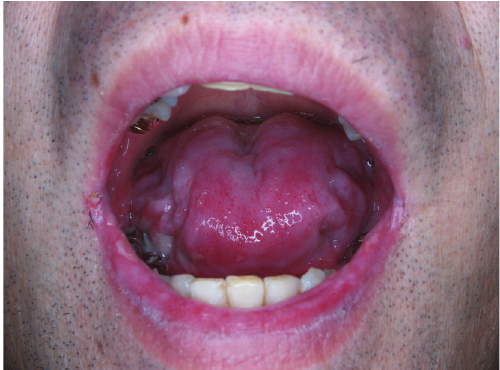
Figure 3: Histological findings of the skin lesion. Subcorneal bulla with mild acantholysis. No interface dermatitis was seen.